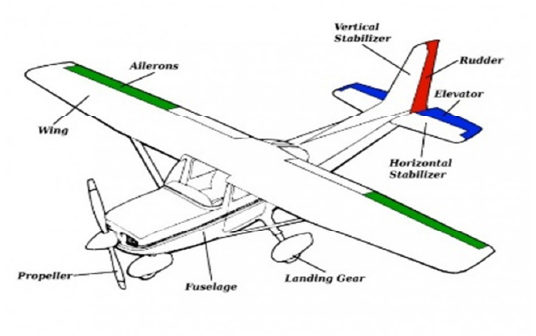
Fig. 1. The Platform of Cessna 172